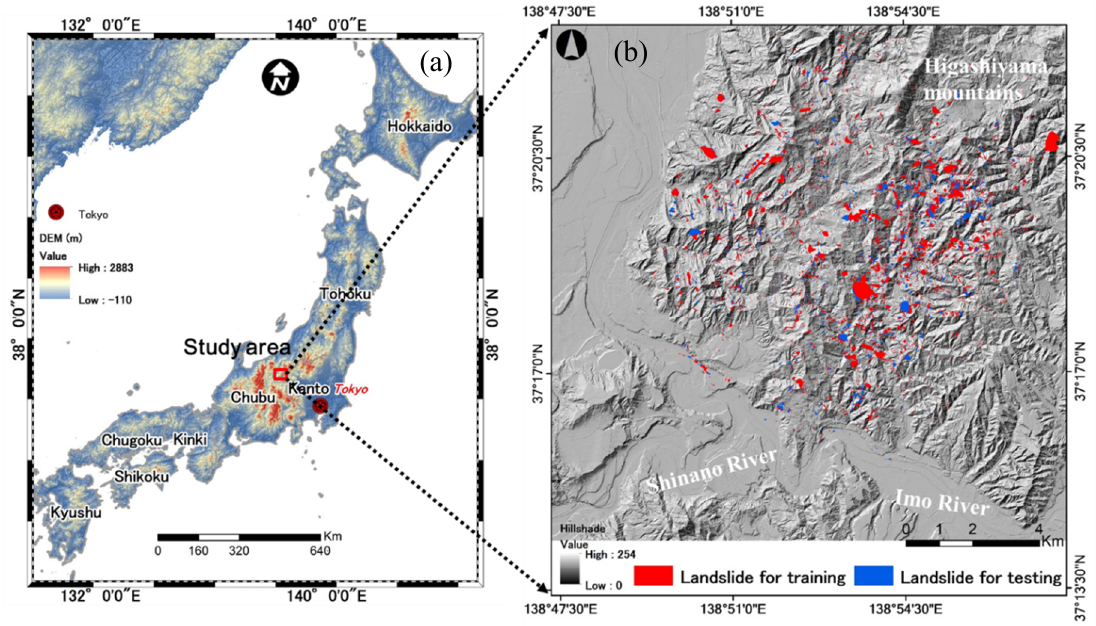
Figure 1. ( a ) Location of Japan; ( b ) landslide distribution, randomly divided into two sets: training and testing.